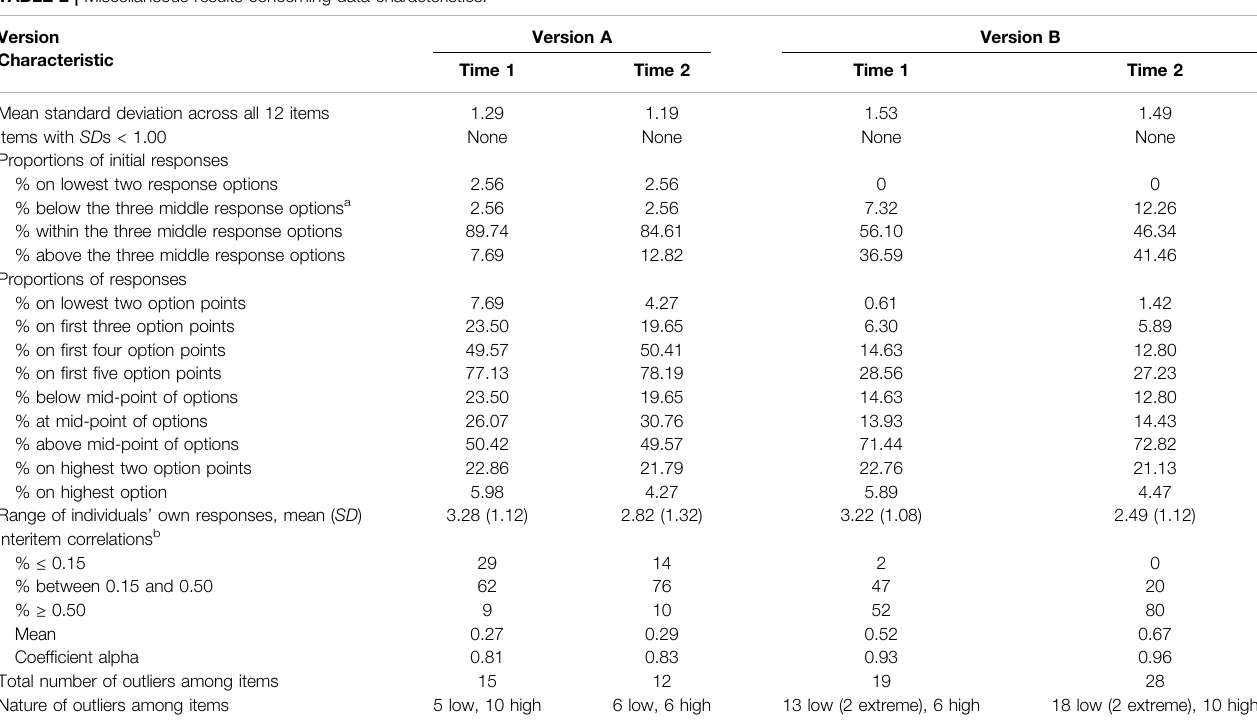
TABLE 2 | Miscellaneous results concerning data